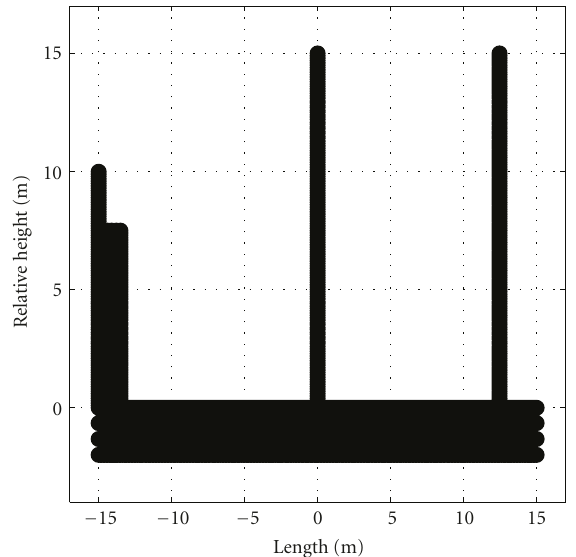
Figure 3: Scatterer distribution for a simulated target illuminated by an LFMCW